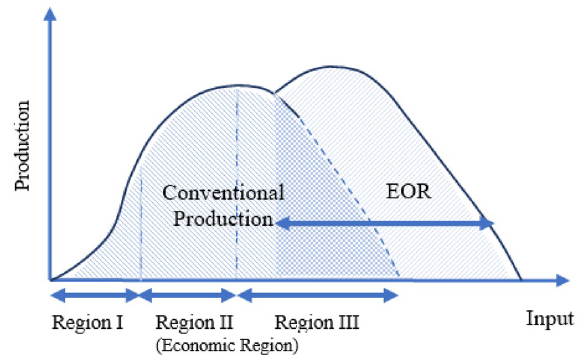
Fig. 10 Oil production during different economic